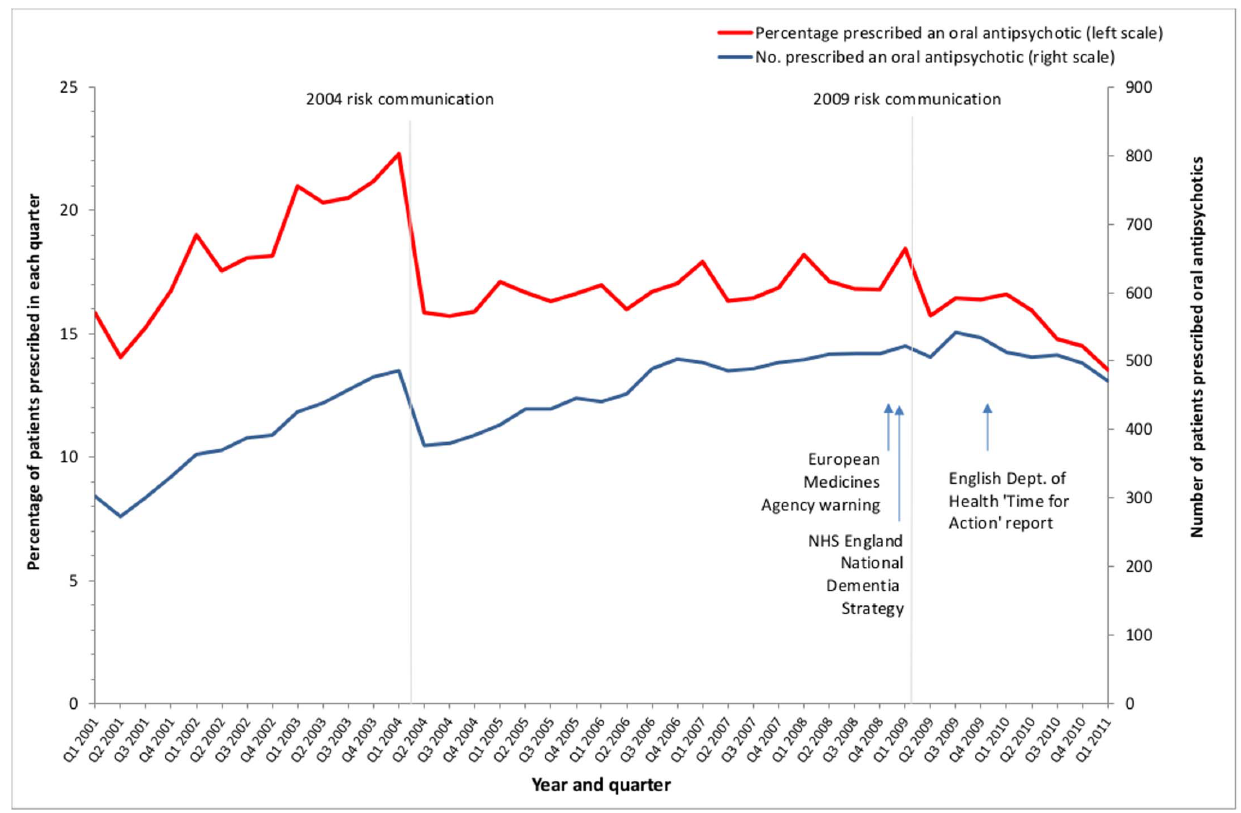
Figure 1. Prescribing of all oral antipsychotics in people aged $ 65 years with dementia.